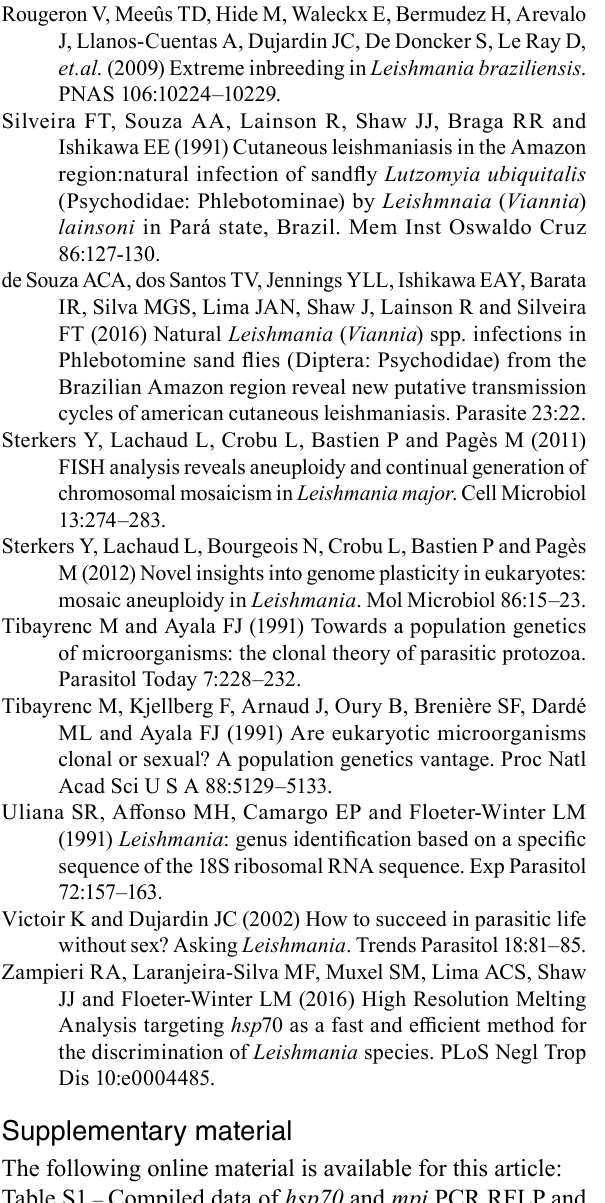
multilocus enzyme electrophoresis (MLEE) from Jennings et al., 2014. Figure S1 – Illustrative gel showing hsp70 and mpi PCR-RFLP ( Hae III) products from cloned parasites fractionated on 3% agarose stained with GelRed. Figure S2 – Alignment of 234 bp fragments used in hsp70- RFLP approach. Figure S3 – Ratio between the intensity of the 180 bp band from L. (V.) guyanensis and the 120 bp band from L. (V.) shawi in heterozygous isolates normalized to a 1:1 ratio parental